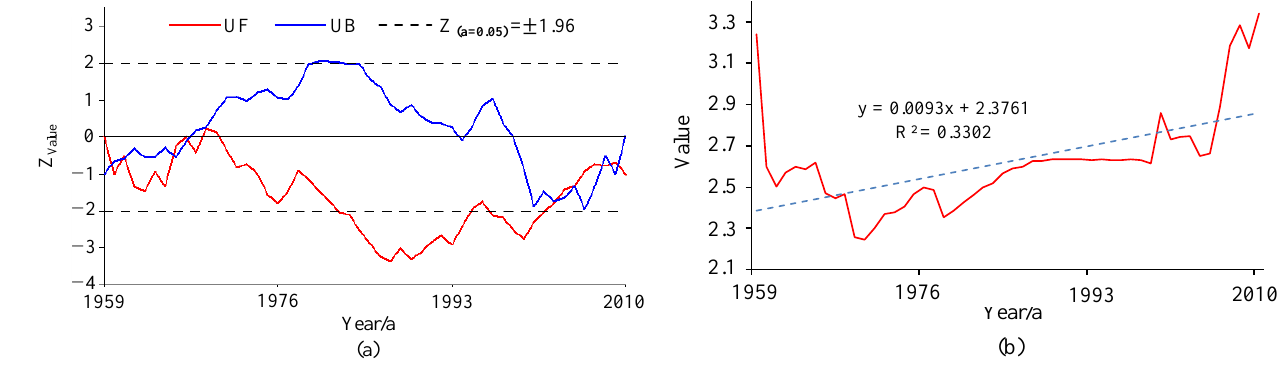
Figure 5. Abrupt runoff transition test chart of Chabagou River Watershed using ( a ) Mann-Kendall mutation trend test; and ( b ) the ordered clustering method. Table 2. Summary of change segment results for hydro-meteorological variables. M-K = Mann-Ken- dall test; O-L = ordered clustering method; C-A = cumulative anomaly method.